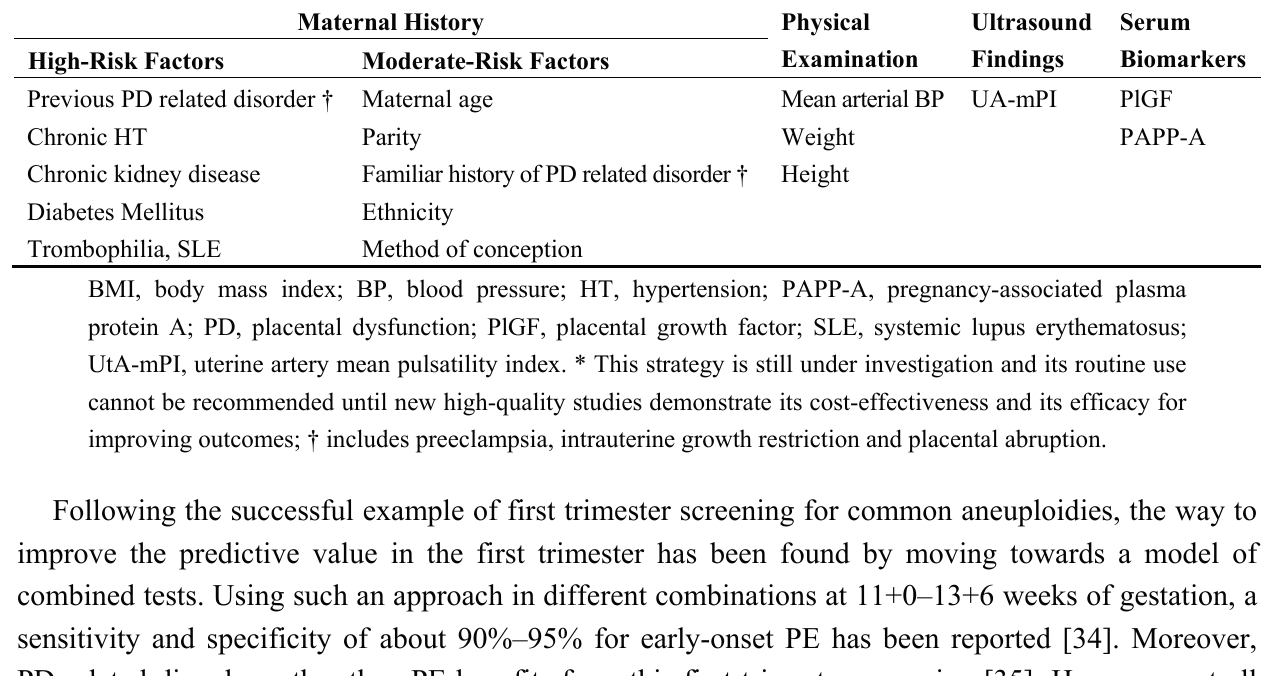
Table 2. Identifiable risk factors used for combined placental dysfunction-related conditions screening at the end of the first trimester